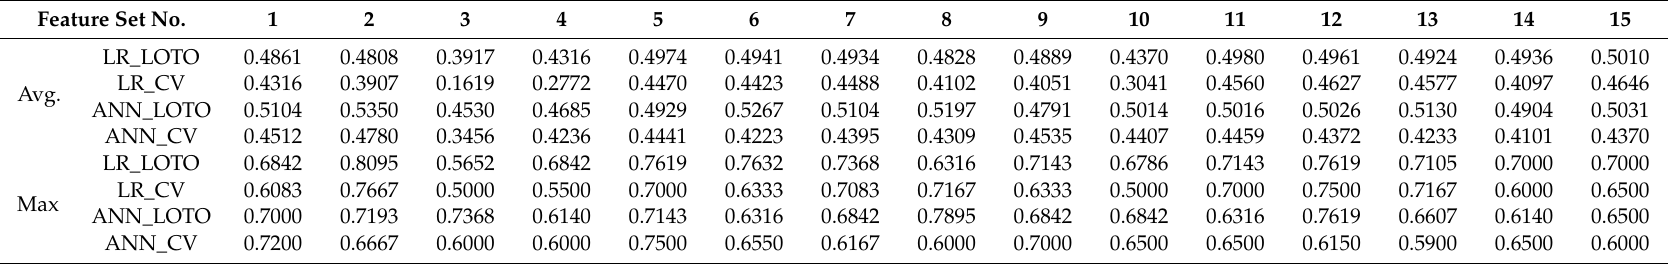
Table A4. Average and maximum decoding accuracies for each feature set using two classifiers with two validation methods (2 s window for EEG features). Feature Set